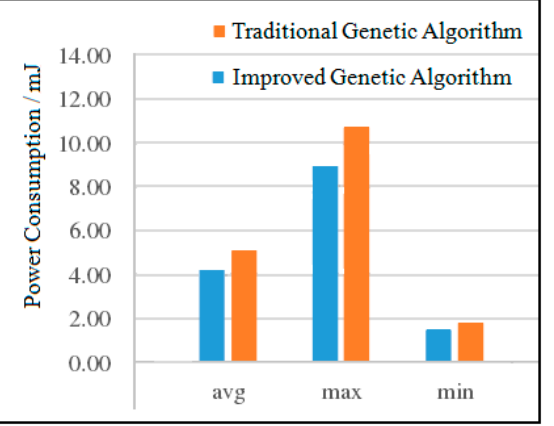
Figure 14. Comparison of the power consumption of the two algorithms for VOPD.